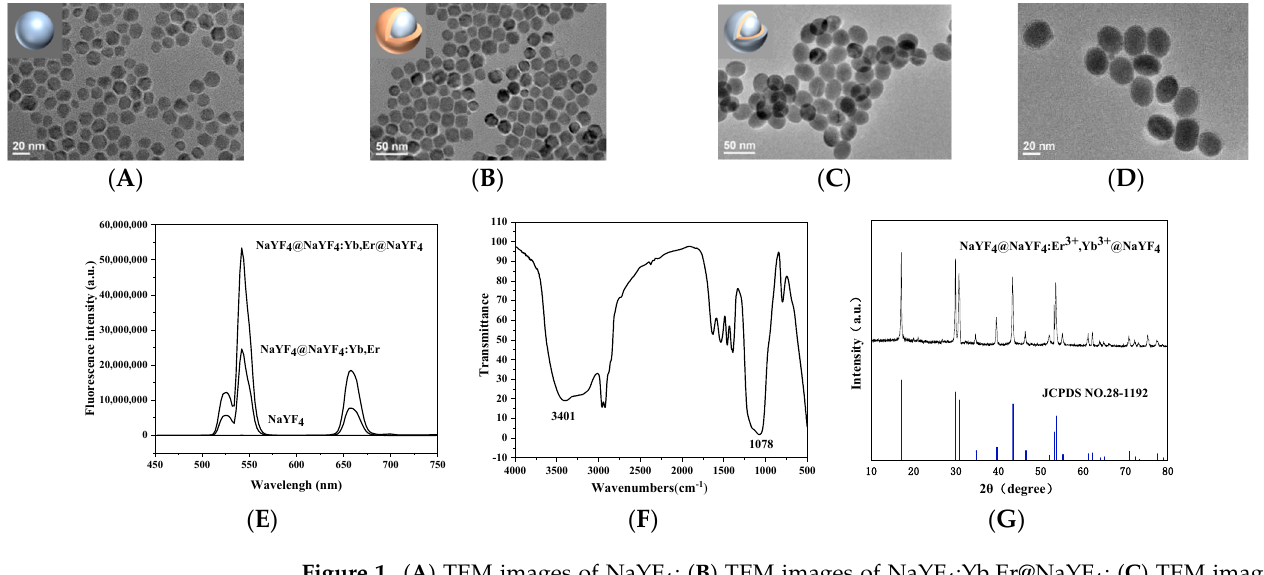
Figure 1. ( A ) TEM images of NaYF 4 ; ( B ) TEM images of NaYF 4 :Yb,Er@NaYF 4 ; ( C ) TEM images of